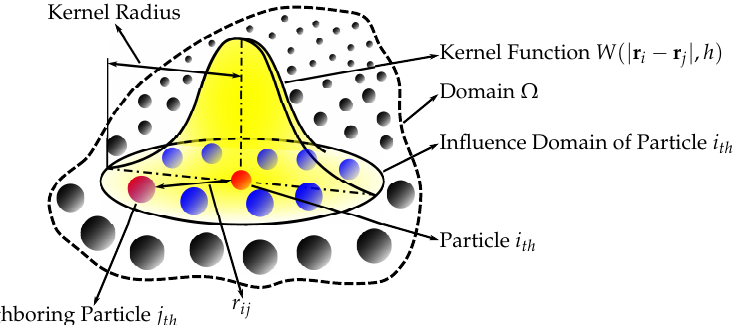
Figure 1. Smoothed-particle hydrodynamics with a kernel